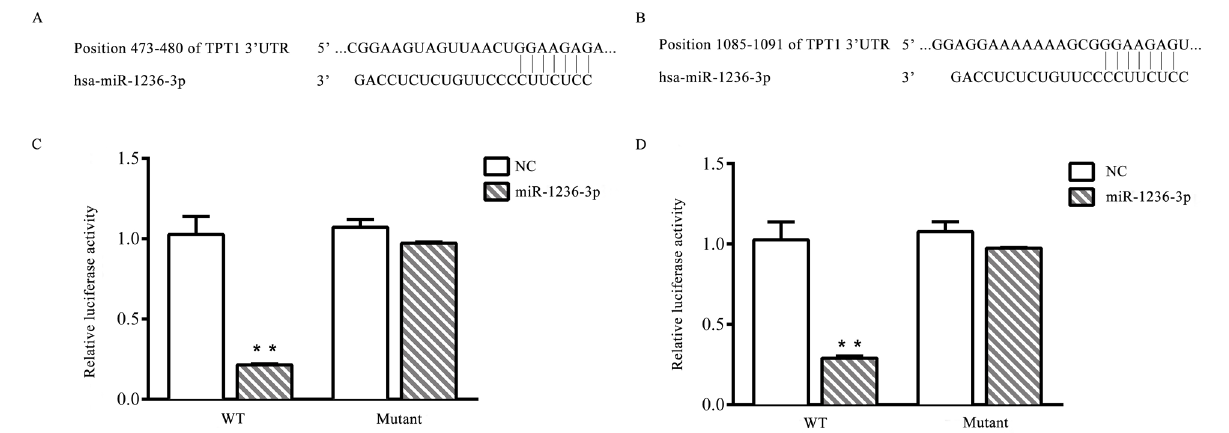
Figure 4: miR-1236-3p directly targets TPT1. (A) Sequence alignment of the paired site of the 3’-UTR of miR-1236-3p and TPT1 (position 473-480); (B) Sequence alignment of the paired site of the 3’-UTR of miR-1236-3p and TPT1 (position 1085-1091); (C-D) The activity of the luciferases in different groups. **P<0.01, miR-1236-3p vs NC group. WT, wild-type; NC, miR-1236-3p mimics negative control-transfected